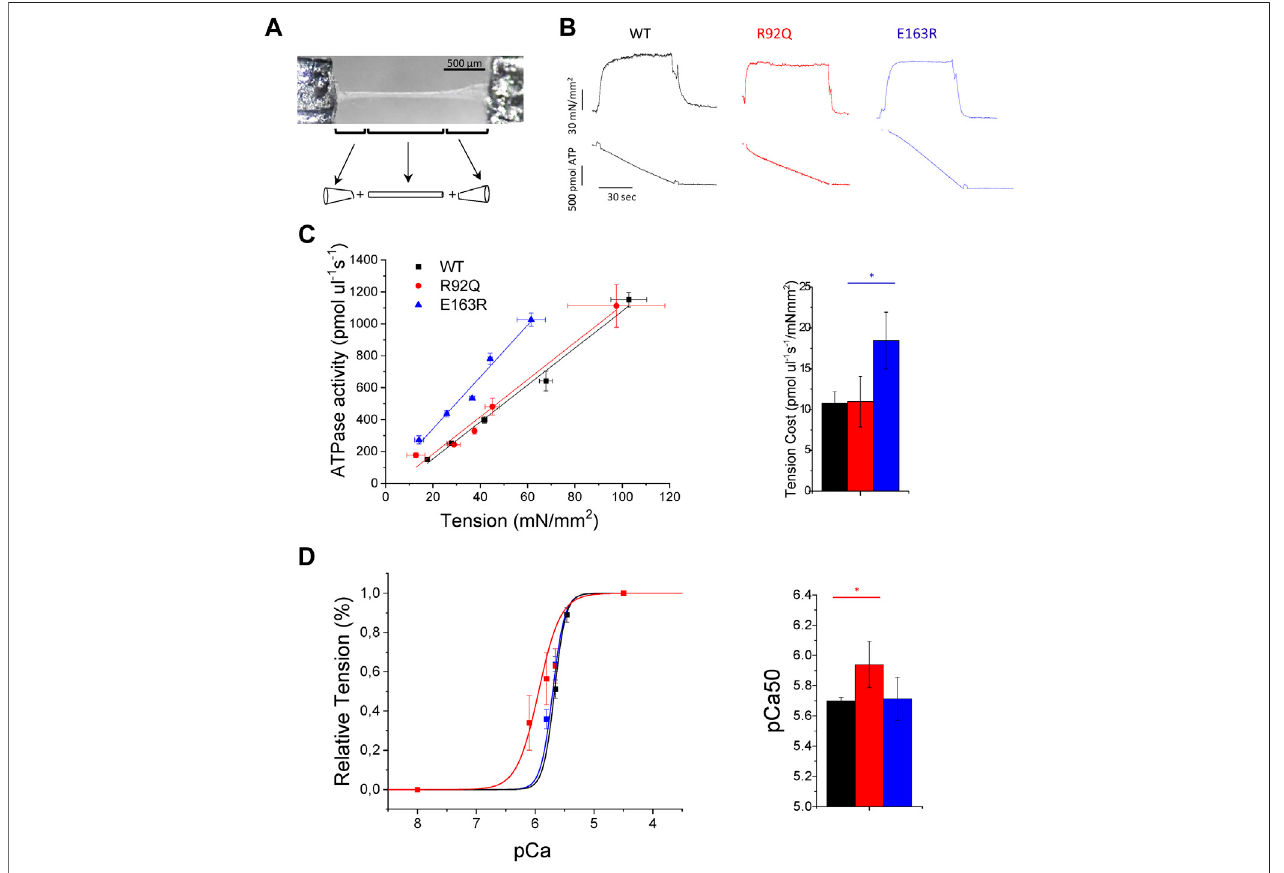
FIGURE 3 | Mechanics and energetics of permeabilized atrial trabeculae from WT and cTnT mutant mouse models. (A) Picture of one permeabilized atrial trabecula with a scheme of the method used to calculate the volume of the trabecula assumed to be a cylinder between two elliptical cones (B) Representative tension (top) and ATPase activity (bottom) traces from wild-type (WT), R92Q, and E163R trabeculae that were maximally Ca 2+ -activated (pCa 4.5) at 20 ° C. Tension cost can be estimated as the ratio between the maximal Ca 2+ -activated ATPase activity and isometric tension (see Table 2 ). (C) Relationship between isometric tension and ATPase activity measured at different pCa ’ s in permeabilized atrial trabeculae from the three groups of mice. The tension cost can be measured from the slope of the ATPase-tension relationship; mean tension cost values are reported at the right. Mean ± SE of tension cost was calculated at 20 ° C. from WT (N = 6, n = 10), R92Q (N = 3, n = 6) and E163R (N = 4, n = 8) mice: N = number of animals, n = number of trabeculae. Statistical test see below (D) pCa- Tension curves (left) and mean values of pCa at half-maximal activation (pCa 50 , right) from WT (N = 5, n = 10), R92Q (N = 3, n = 7) and E163R (N = 4, n = 9)